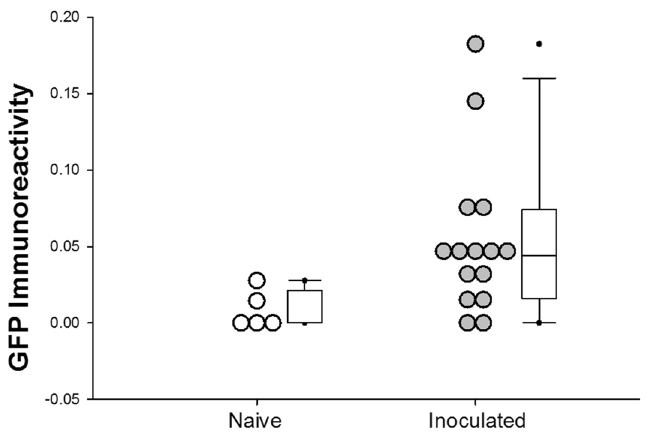
Figure 3. GFP ELISA of fetal cerebral cortex. Results of ELISA for GFP immunoreactivity of fetal cerebral cortex in animals whose mothers received an intravenous inoculation of 10,000 CFU of GFP-labeled S. aureus intravenously. Box and whisker plot with median (horizontal line) denoted, boundaries of box indicate 25th and 75th percentiles. Individual data are shown as open (naïve: uninoculated) or filled (inoculated) symbols. Whiskers (error bars) indicate 90th and 10th percentiles. * p < 0.05.